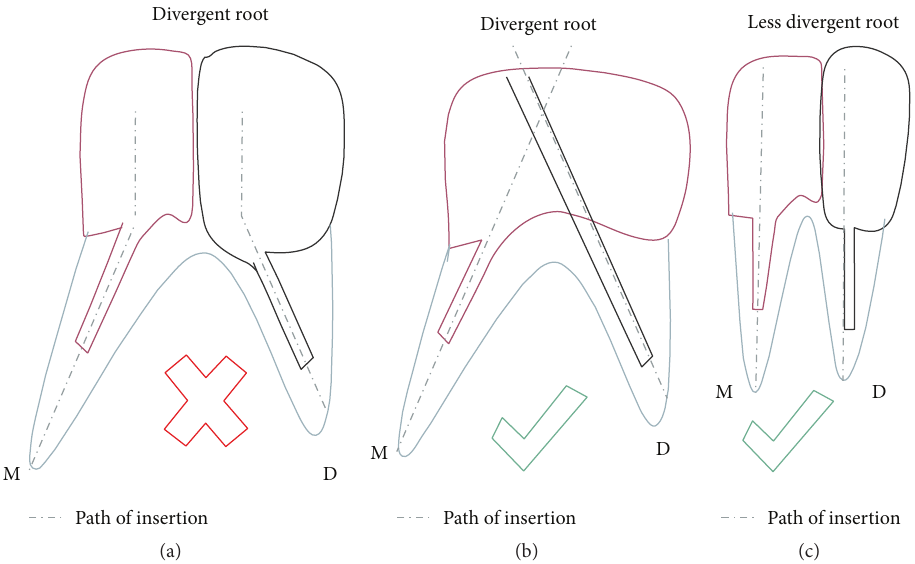
Figure 3: Line diagram showing different type of designs made according to the anatomy of root. In teeth with divergent roots the paths of insertion of the two posts (a) coincide with each other, so it is difficult to prepare the wax pattern. Hence in such cases the design in (b) is suggested, while in teeth with lesser divergence design in (c) is suggested.